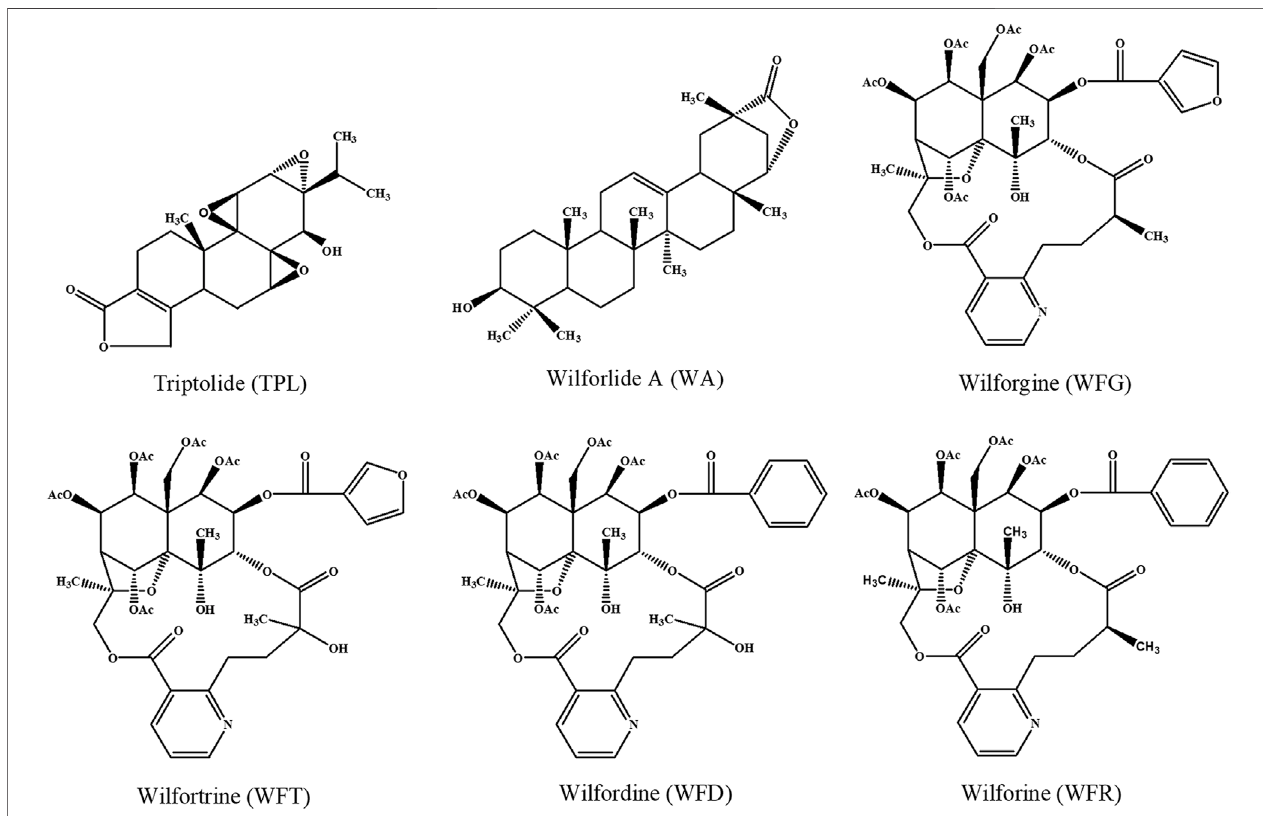
FIGURE 1 | Chemical structures of the six key TGT